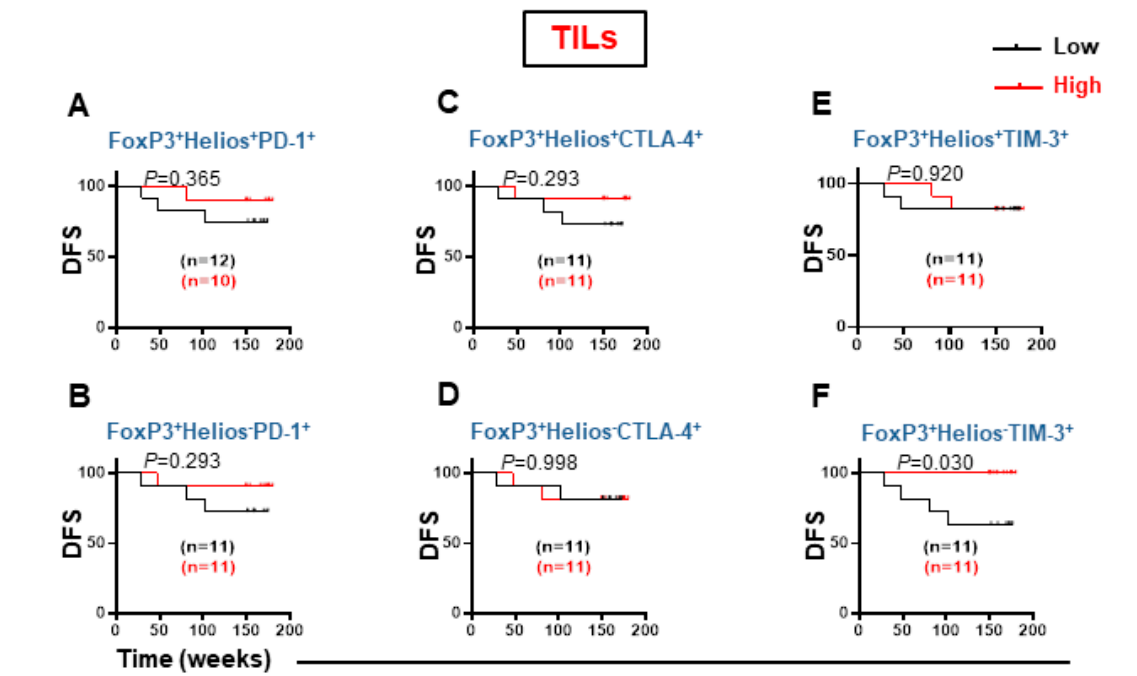
Figure 6. Kaplan–Meier survival curves for DFS based on the levels of FoxP3 + Helios + and CD3 + CD4 − FoxP3 + Helios − CD3 + CD4 − T cells expressing PD-1, CTLA-4, and TIM-3 in TILs. FoxP3 + Helios + PD-1 + ( A ), FoxP3 + Helios − PD-1 + ( B ), FoxP3 + Helios + CTLA-4 + ( C ), FoxP3 + Helios − CTLA-4 + ( D ), FoxP3 + Helios + TIM-3 + ( E ), and FoxP3 + Helios − TIM-3 + ( F ) cell subsets were grouped into low and high groups, and DFS determined. The number of patients included in each comparison are specified on each survival curve.